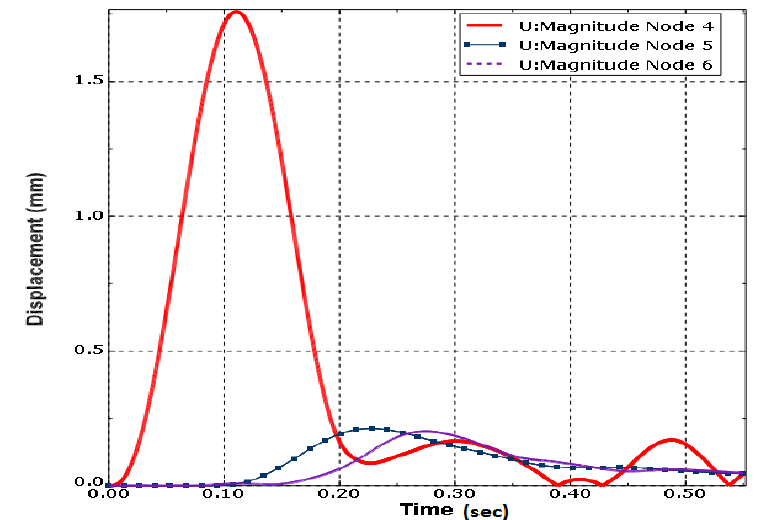
Figure 9. Numerical simulation results of SASW test using quarter circular soil medium.